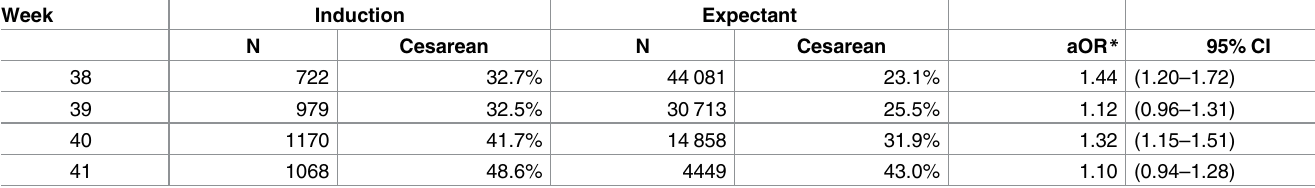
Table 2. Risk of cesareandelivery associated with induction of labor at a given gestational age, compared to expectant management with delivery at a later gestation, among pregnancies with large-for-gestational-age infants (90 th centile and